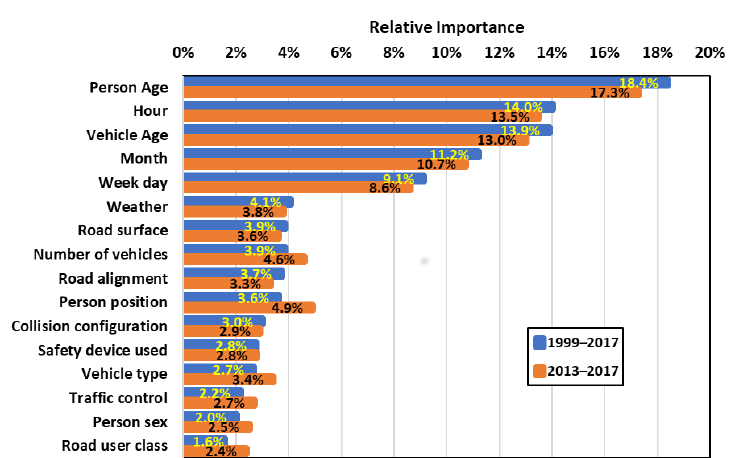
Figure 4. The importance of factors influencing the severity of a collision with a parked vehicle for all available factors in the dataset.